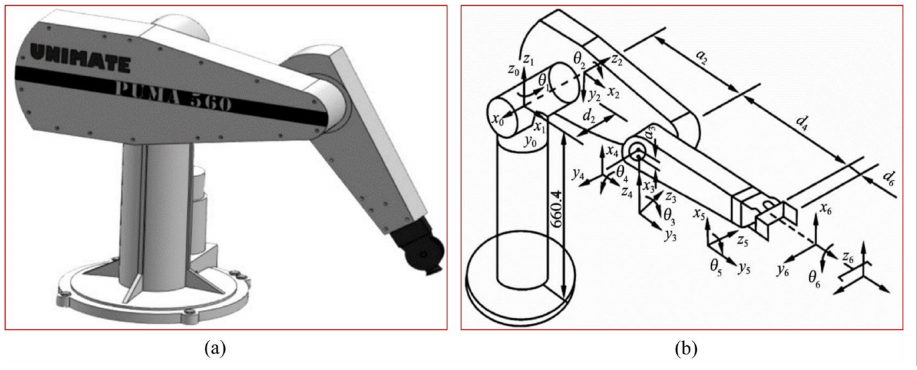
Figure 1. ( a ) Physical model; ( b ) D‑H coordinate